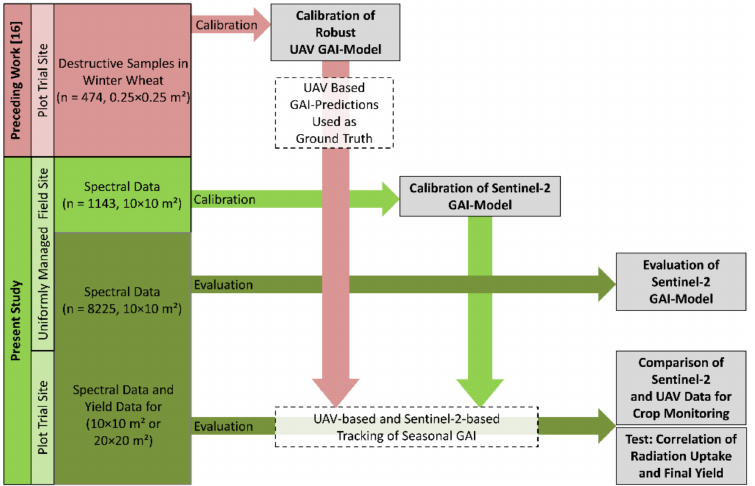
Figure 3. Overview of datasets and workflow (red: precedent work by Bukowiecki et al. [16], green: present study). The different objectives are depicted by grey boxes.